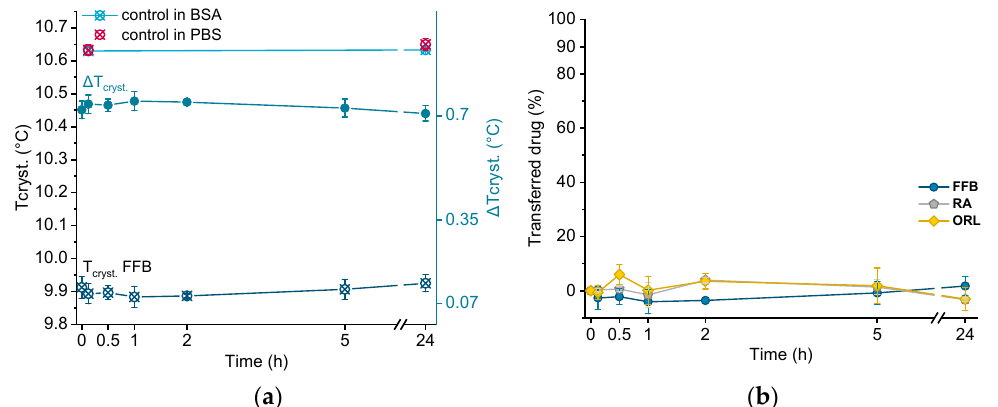
Figure 6. ( a ) Crystallization temperatures (T cryst. ) of unloaded trimyristin emulsion (control) and fenofibrate-containing emulsion (FFB), as well as the change of T cryst. ( Δ T cryst. ) within 24 h. ( b ) Transferred percentage of fenofibrate (FFB), retinyl acetate (RA), and orlistat (ORL) to the BSA fraction.